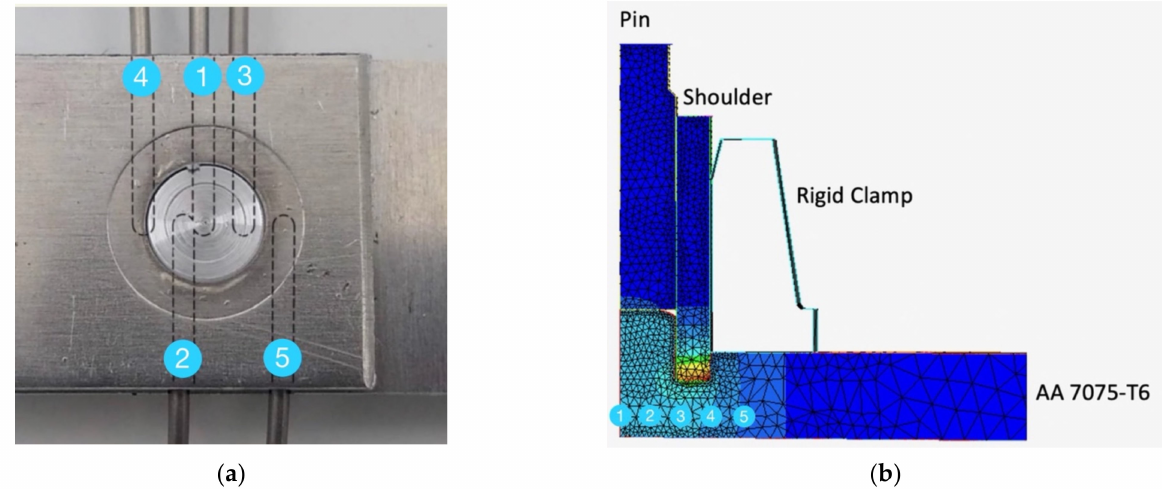
Figure 6. Thermocouple layout for the ( a ) welding process and the ( b )